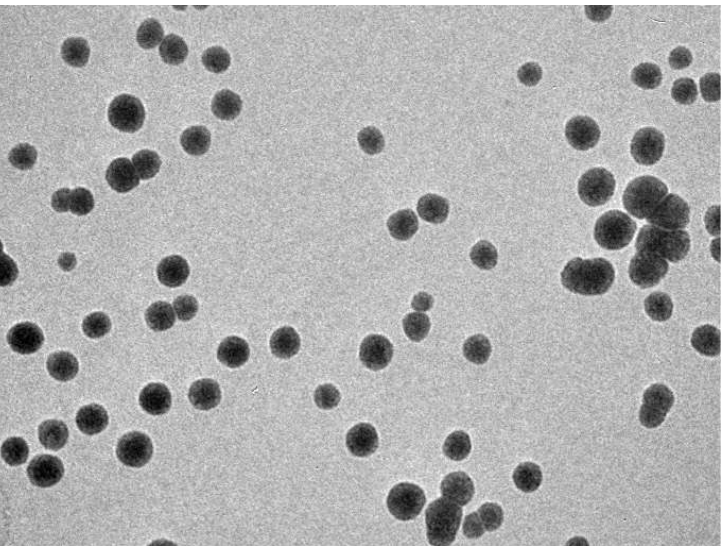
Figure 1. Surface morphology of IPI chitosan vesicles using a transmission electron microscope.